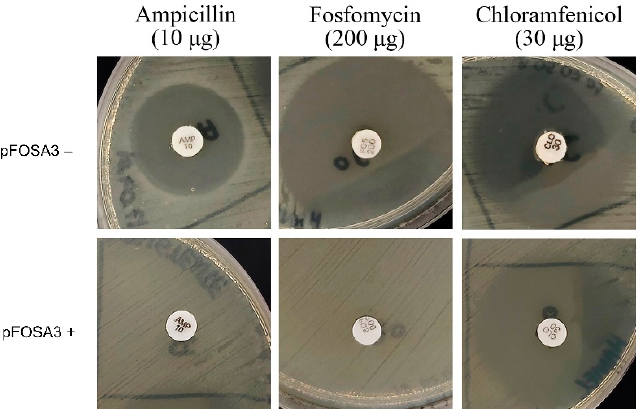
Figure 2. Confirmatory disk diffusion of the resistant phenotype of pFOSA3 + E. coli TOP10. Representative photographs of disk diffusion plates obtained in one of the assays.